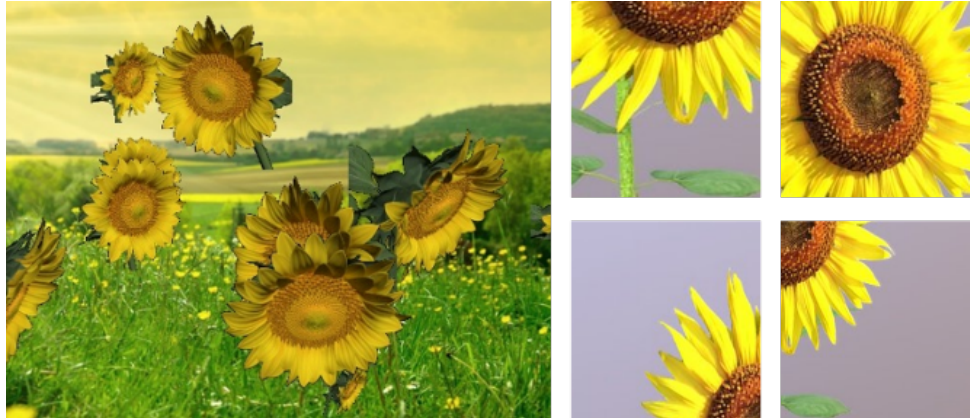
Figure 7. ( Left ): 3D generated sunflowers for the flower detector. ( Right ): Generated images for direct visual servoing approach.